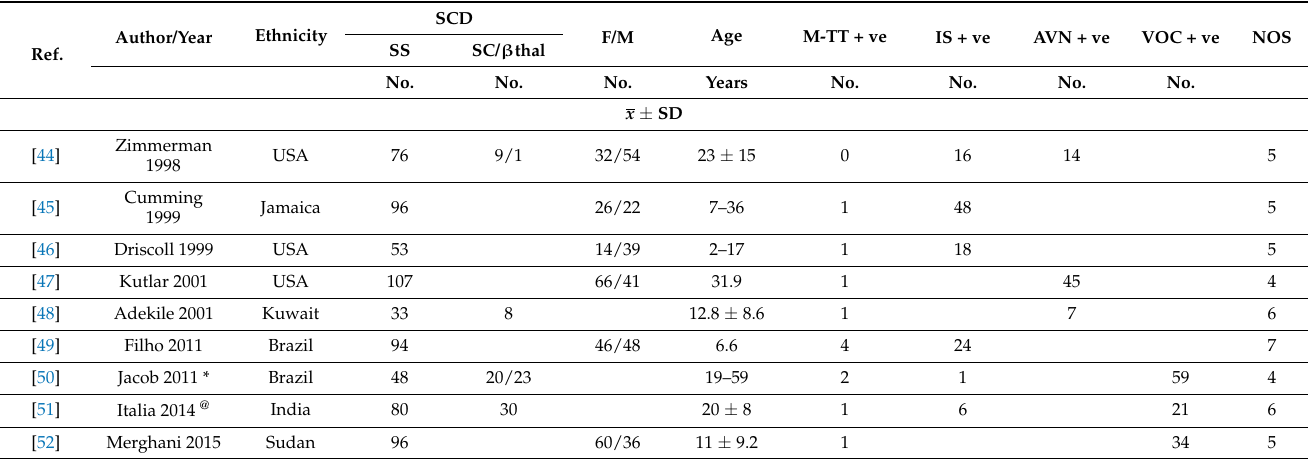
Table 3. Demographics and clinical features of the cohort studies on the methylenetetrahydrofolate reductase TT genotype.